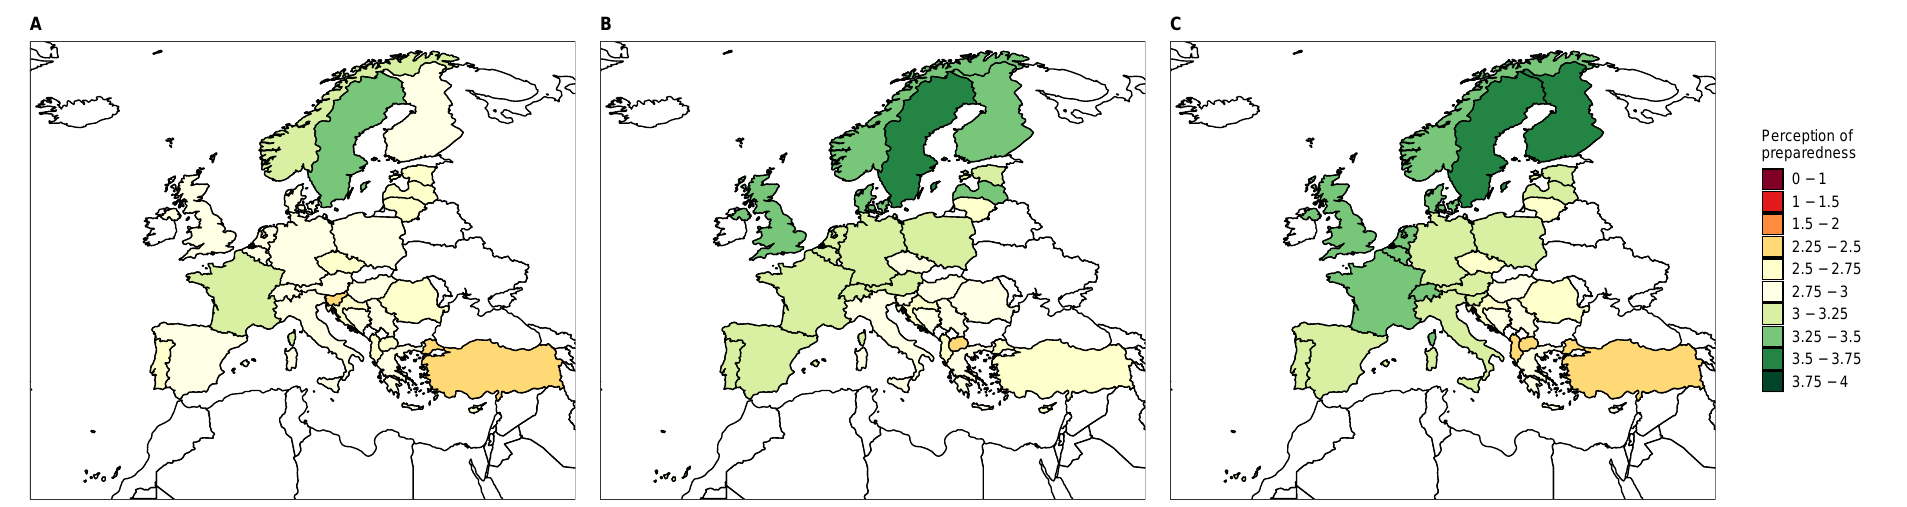
Figure 1. Average perception of preparedness in topics related to pharmacology of antimicrobial agents ( A ), clinical use of antimicrobials agents ( B ), and antimicrobial resistance ( C ).